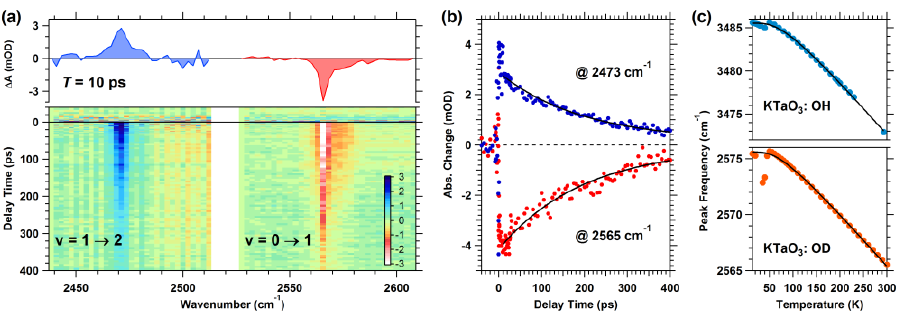
Fig. 2. (a) Two-dimensional map of the pump-probe signal of the OD mode in KTaO 3 . The bleaching signal of the v=0→1 transition and the induced absorption signal of the v=1→2 transition are observed. Transient absorption spectrum at T = 10 ps is shown in the upper part. (b) Time evolution of the 0-1 bleaching signal at 2565 cm -1 (red) and the 1-2 excited state absorption signal at 2473 cm -1 (blue). Black curves are the exponential fittings to them. (c) Temperature dependencies of the peak frequencies of OH (upper) and OD (lower) modes. Black curves are the fittings with Eq.